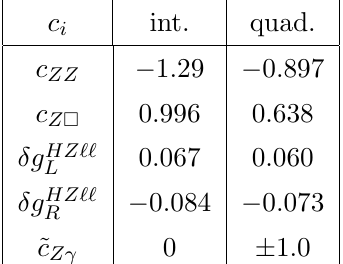
Table 1. Values of the Higgs basis parameters which modify the H about 30%. These values are derived considering linear (int.) and quadratic (quad.)